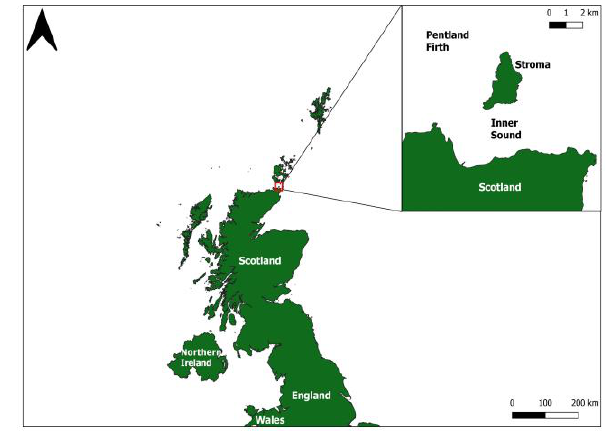
Fig. 1. The Inner Sound area of the Pentland Firth, Scotland,